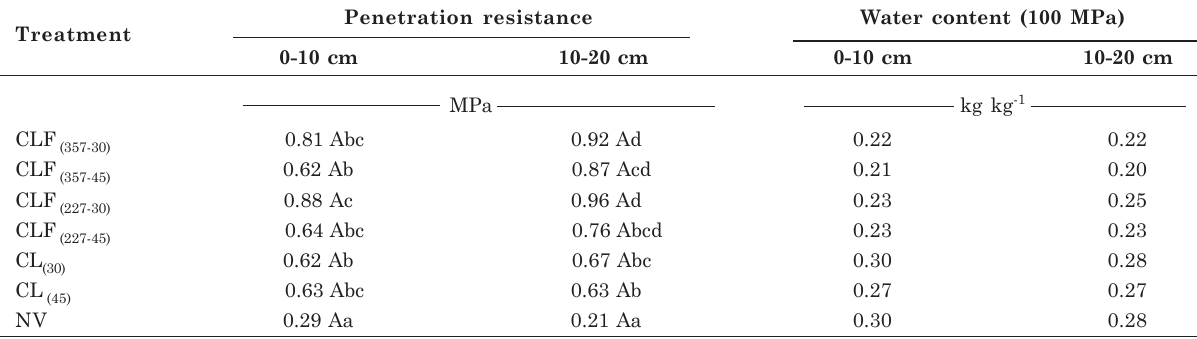
Mean values with same uppercase letter at the depth and lowercase letter in the treatment do not differ among themselves in the LSD test Table 3. Water stable aggregate size distribution at the depths and in the treatments studied Treatment